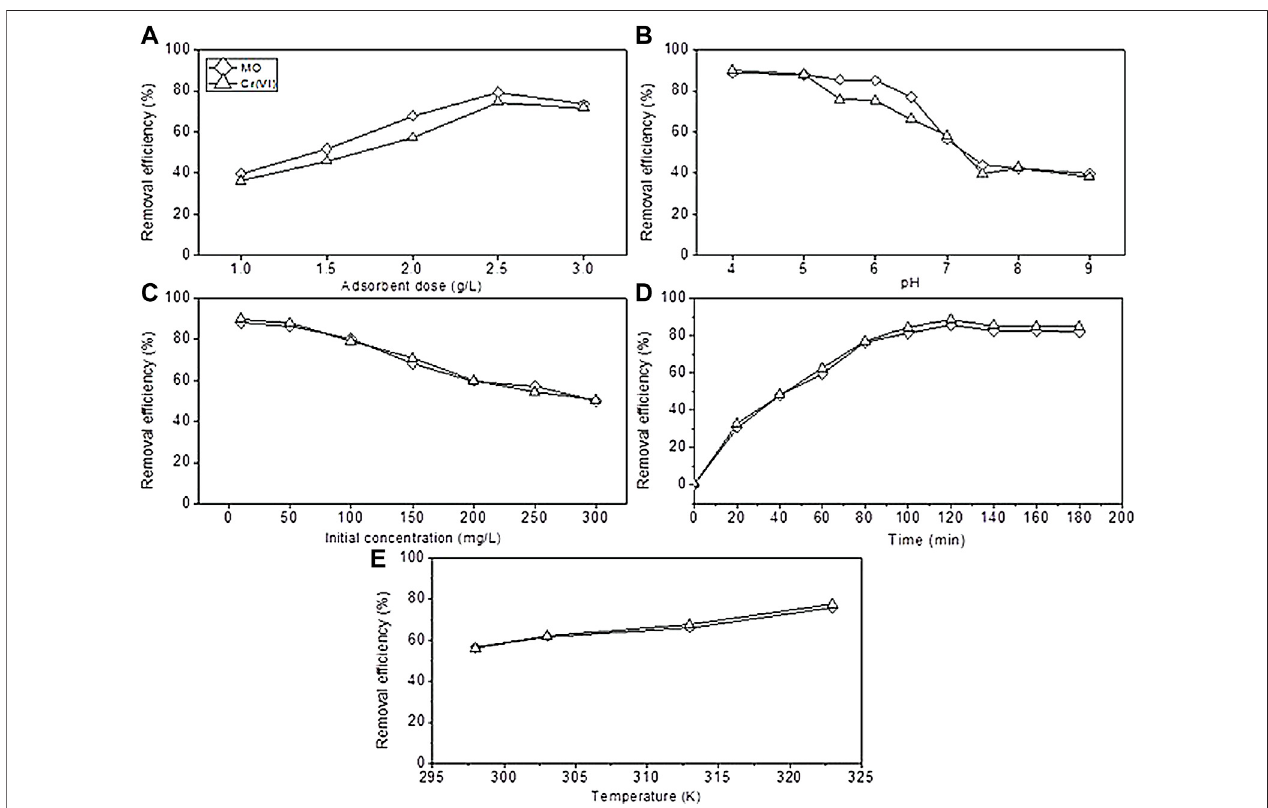
FIGURE 5 | Effect of operational parameters. (A) Adsorbent dose, (B) pH, (C) initial concentration, (D) time, and (E) temperature.